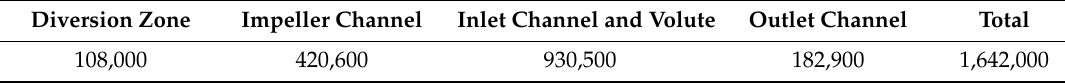
Figure 3. Mesh section of the simulation model of the flow field of the blood pump; the mesh with smaller characteristic scale was refined and densified. Table 1. Number of grid units in each part of the blood pump simulation model.